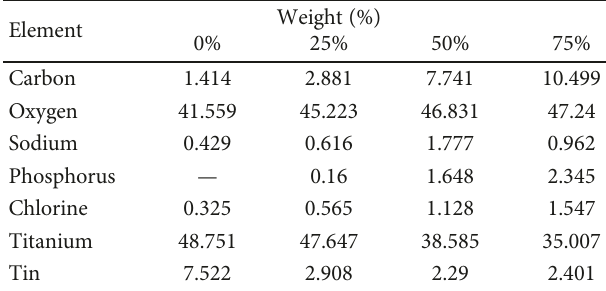
Table 1: Element content of DSSC in various clathrin